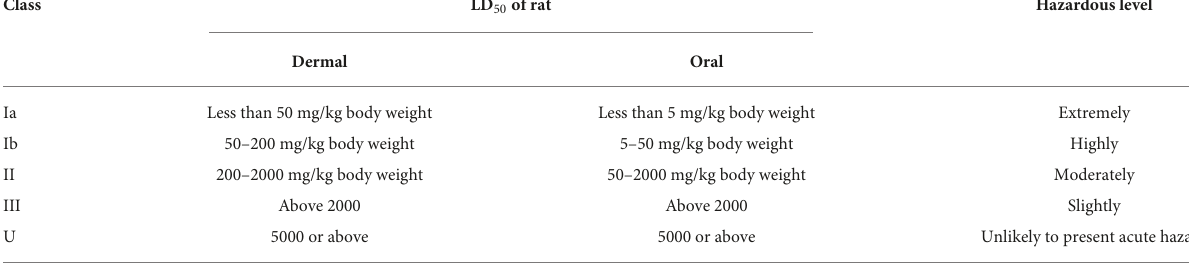
TABLE 2 Pesticides classification according to WHO guidelines (World Health Organization, 2009).